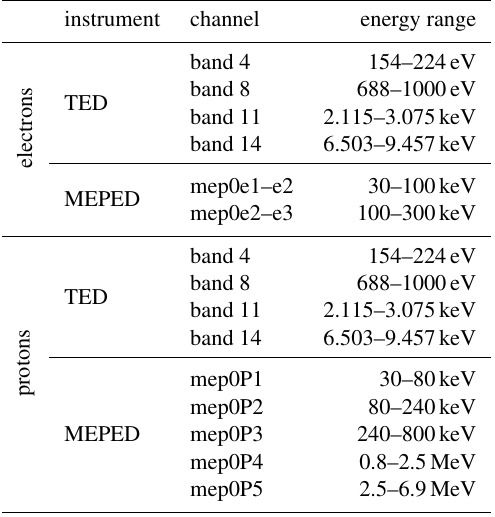
Table 1. Channels and nominal energy ranges from the POES and METOP satellites which have been